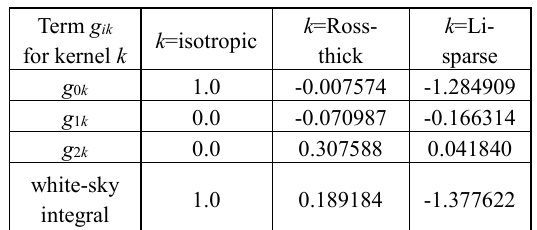
TABLE I. Coefficients used for calculating black-sky and